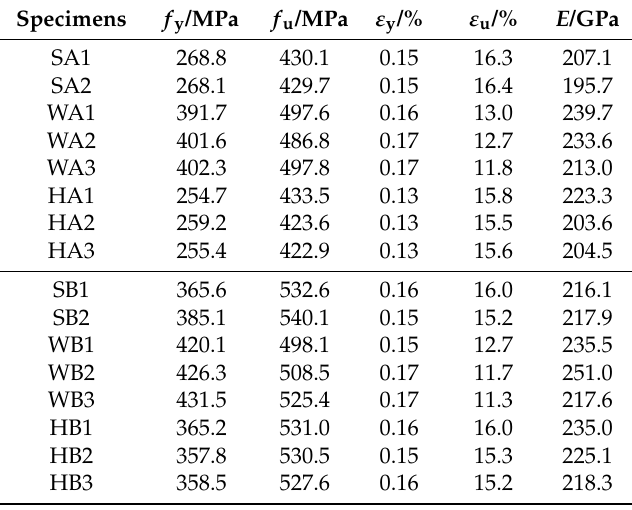
Figure 4. Cyclic loading patterns. ( a ) For all No. (1) specimens; ( b ) For all No. (2) specimens; ( c ) For all No. (3) specimens. Table 2. Mechanical parameters under monotonic loading.